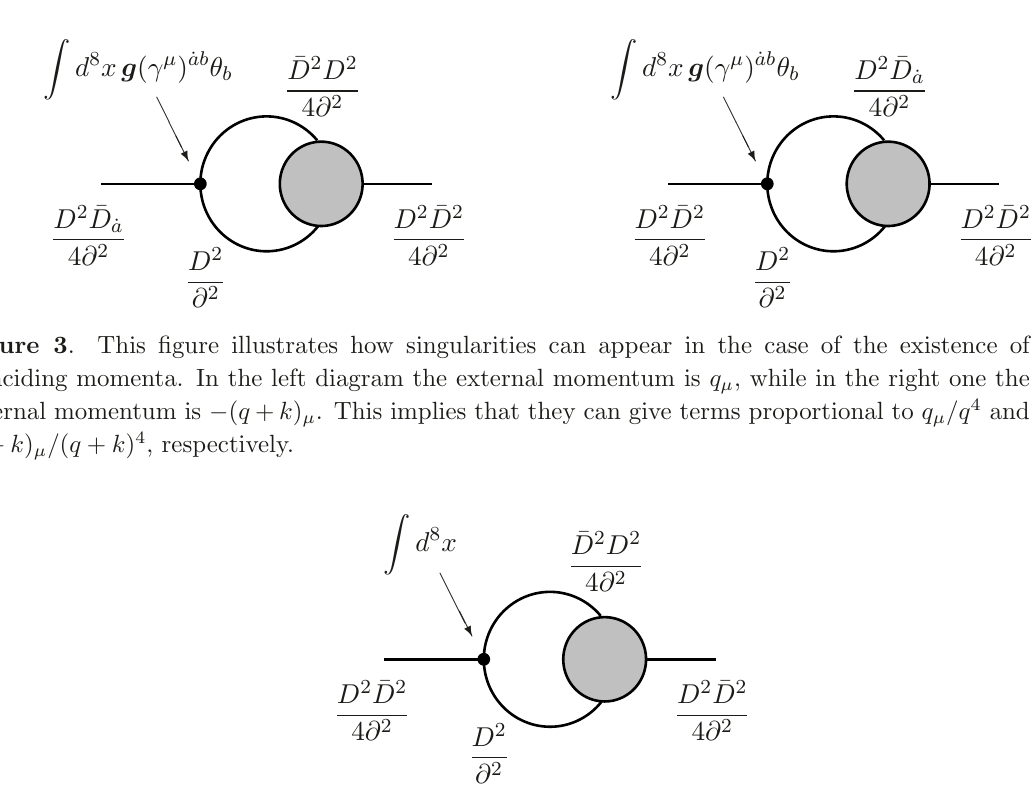
Figure 4 . Usual subdiagrams corresponding to the insertion of the two-point Green function of the matter superfields with a Yukawa vertex in the left